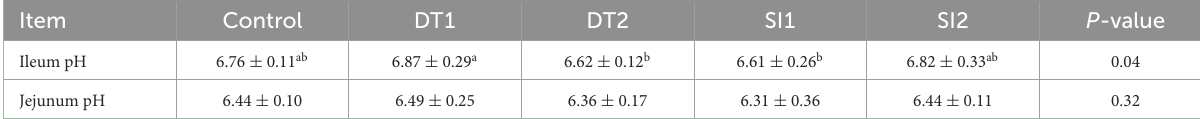
TABLE 5 Effects of dietary supplementation with dandelion tannins or soybean isoflavones on the intestinal pH of Wenchang chickens. Item